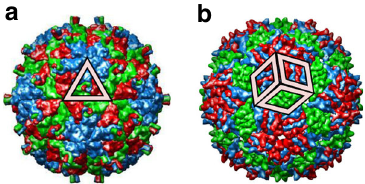
Fig. 4 Capsid protein interfaces are constrained by icosahedral geometry. The classi fi cation of icosahedral designs distinguishes between capsid layouts of viruses formed from the same number of proteins. Examples of a triangle and rhomb tiling are shown: a Pariacoto virus ( T D ð 1 ; 1 Þ ); b MS2 ( T D t ð 1 ; 1 Þ ). Tiles are shown superimposed on fi gures adapted from the